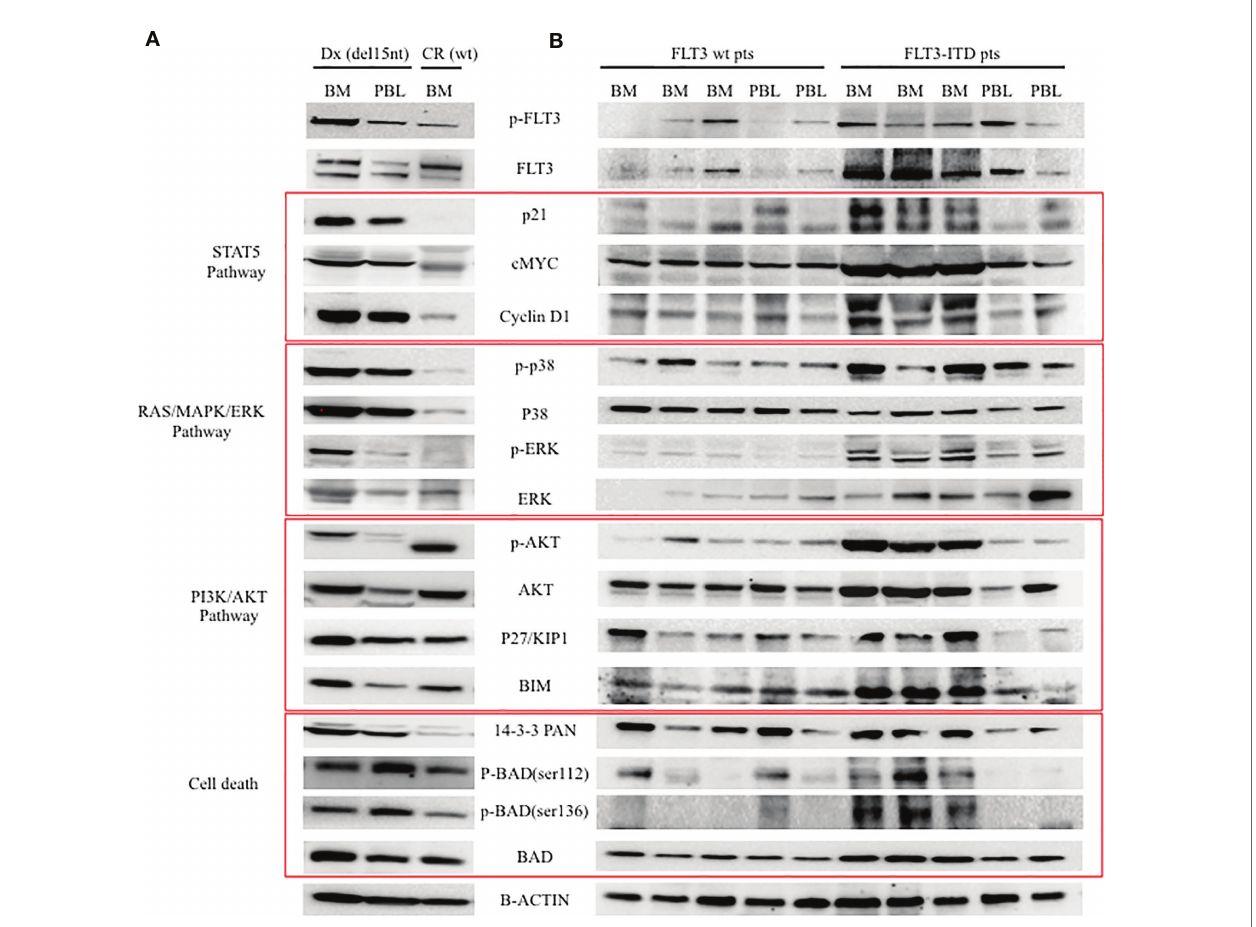
FIGURE 3 | Western blot analysis of FLT-3 expression and of its down-stream signalling pathway. (A) Analysis of patient cells at two different time points (Dx: diagnosis with FLT3 carrying the c.1770_1784del15; CR: complete remission with wt FLT3). (B) Analysis of 5 AML patients with wt FLT3 along with 5 patients carrying FLT3-ITD, used as control of FLT3 downstream signalling. BM, bone marrow; PBL, peripheral blood.